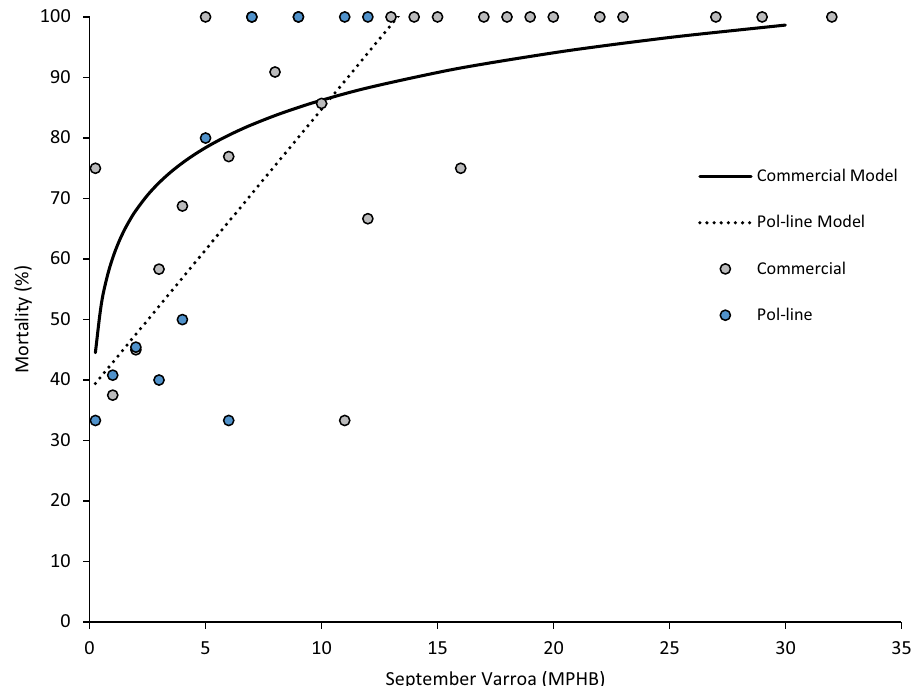
Figure 6. Predictive relationship between September Varroa levels and colony mortality ( N Commercial = 167, N Pol-line = 157). Points are based on binned data from all colonies falling into a Varroa stratum, and concordant percentage mortality. Colours (Commercial, grey; Pol-line, blue), and line types (Commercial, solid; Pol-line, dashed), indicate stock. Lines are fit against the binned data for each stock (Commercial, R 2 = 0.349, Pol-line, R 2 =